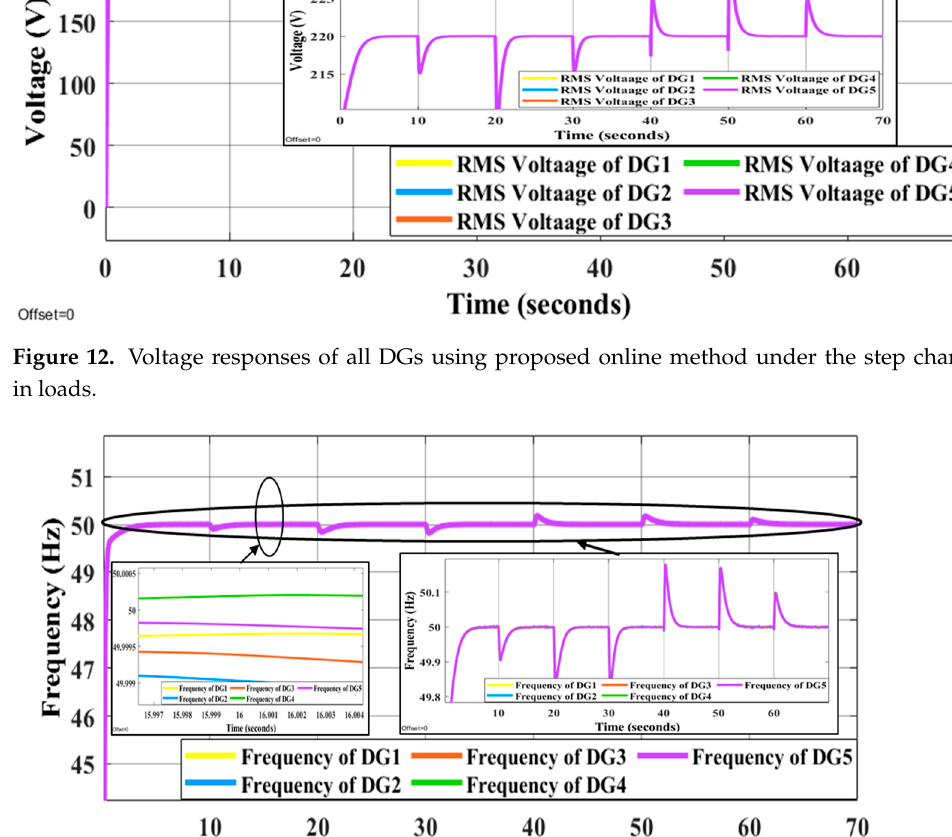
Figure 15. Reactive power of all DGs under the changing of load conditions.